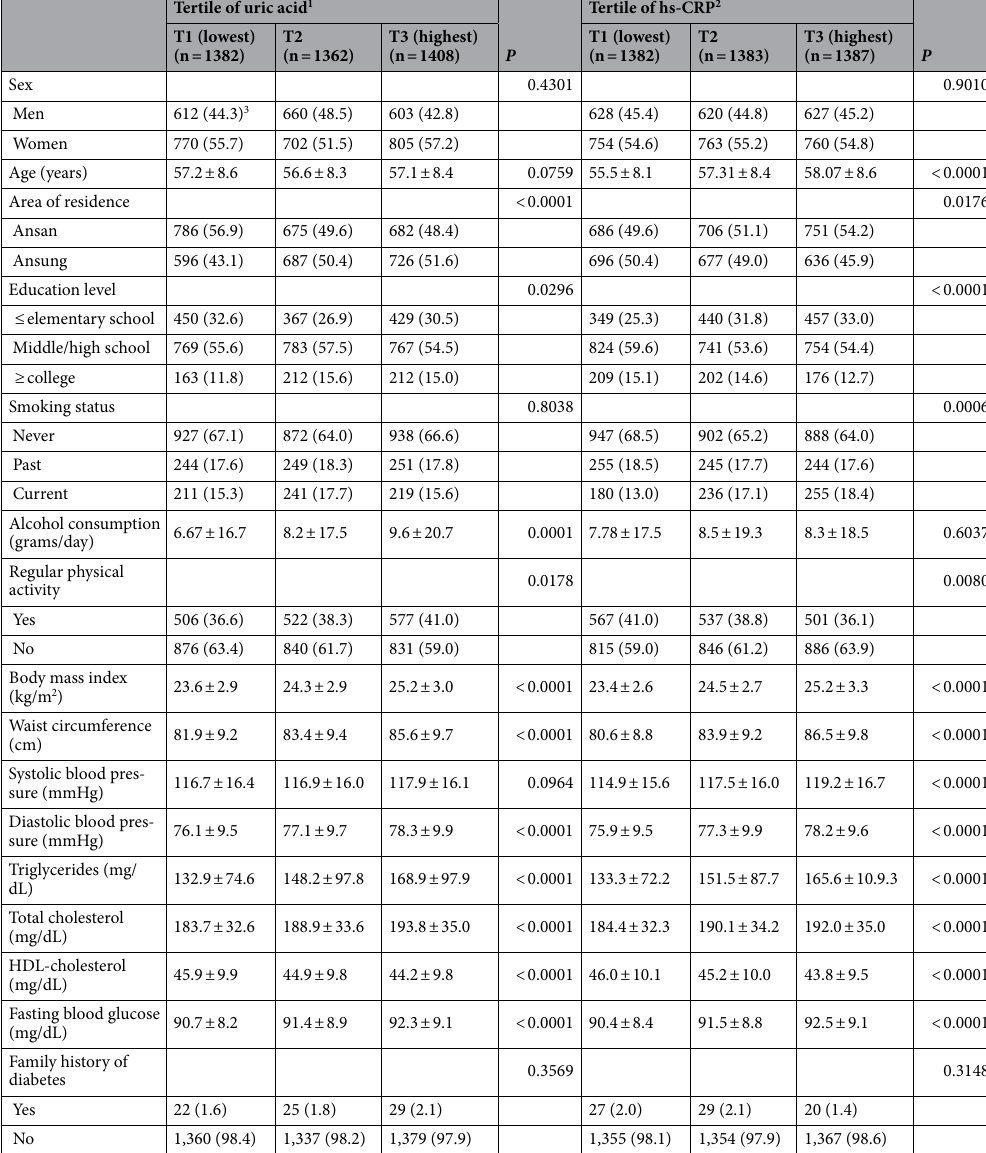
Table 1. Baseline characteristics of the study participants by tertile of serum uric acid and high-sensitivity C-reactive protein levels in Korean adults aged 45–76 years. T tertile; hs-CRP high-sensitivity C-reactive protein; HDL-cholesterol high-density lipoprotein cholesterol. 1 Cut-offs for tertiles 1–3 of serum uric acid levels are as follows: < 5.2, 5.2–6.1, and > 6.1 mg/dL in men and < 3.8, 3.8–4.4, and > 4.4 mg/dL in women, respectively. 2 Cut-offs for tertiles 1–3 of hs-CRP levels are as follows: < 0.45, 0.45–1.04, and > 1.04 mg/L in men and < 0.38, 0.38–0.89, and > 0.89 mg/L in women, respectively. 3 Values are number (percentage) for categorical